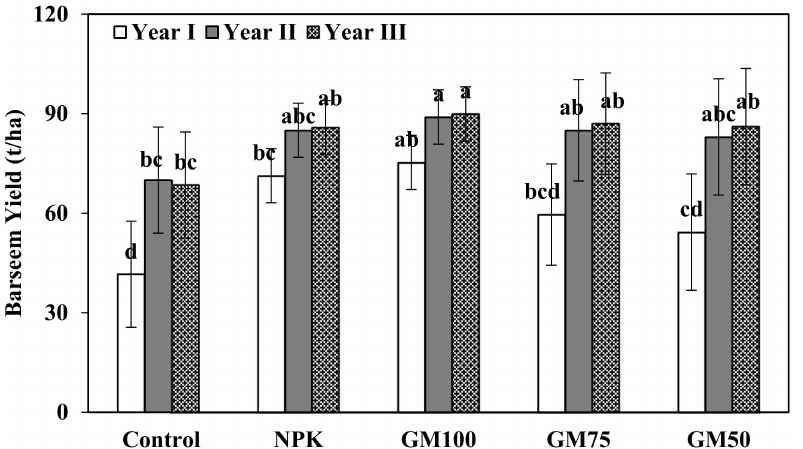
Figure 2. Effect of green manuring on berseem yield. Control (without any chemical or green manuring amendment), NPK (no green manuring, 100% recommended nitrogen, phosphorus, and potassium-NPK), GM 100 (green manuring + 100% recommended NPK), GM 75 (green manuring + 75% recommended NPK), and GM 50 (green manuring + 50% recommended NPK). Blank column shows first year, grey filled second year, and pattern filled shows third year data. Columns sharing the same letters are not significantly different at p ≤ 0.05 probability